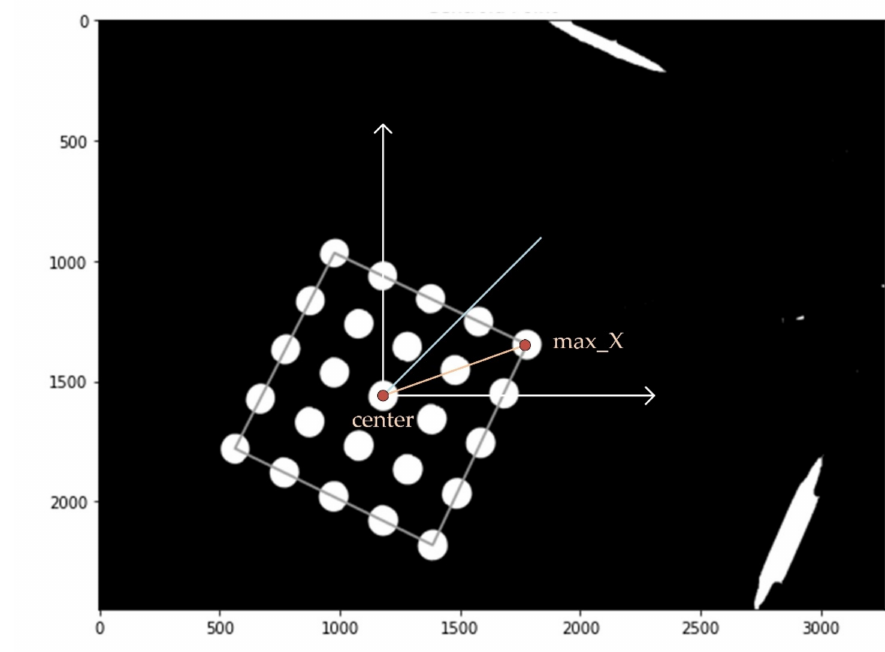
Figure 8. Method of determining the center and rotation angle of each quadrant